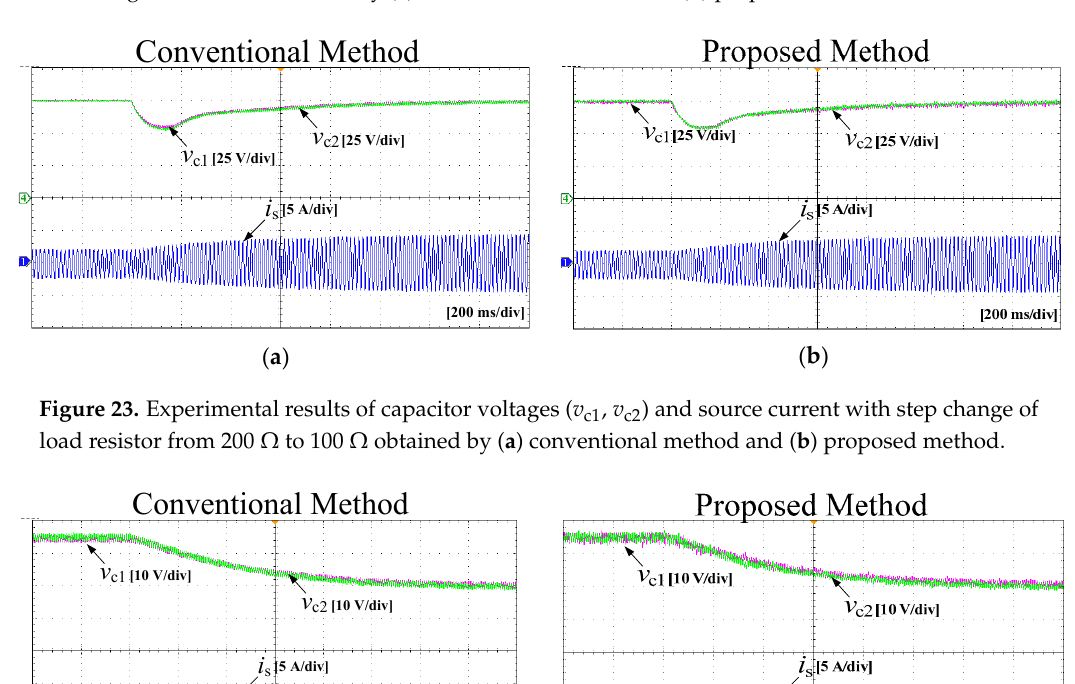
Figure 22. Experimental results of capacitor voltages ( v c1 , v c2 ) and source current during imbalanced NP voltage conditions obtained by ( a ) conventional method and ( b ) proposed method.